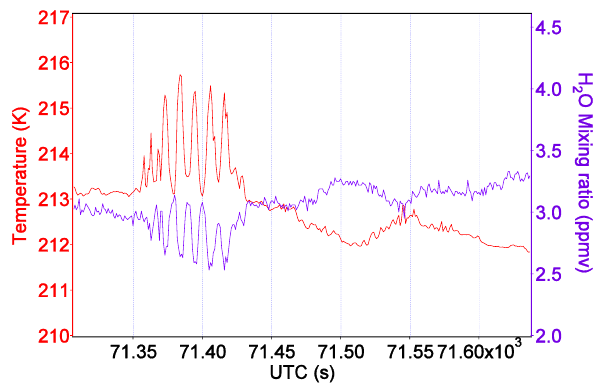
Fig. 2. In-flight synchronization between temperature ( T ) and water vapor (H 2 O) measurements. Fluctuations in T (red) and H 2 O (pur- ple) due to a gravity wave were observed during RF08 of START08. These fast fluctuations demonstrate the accurate synchronization of T and H 2 O measurements at the 1Hz